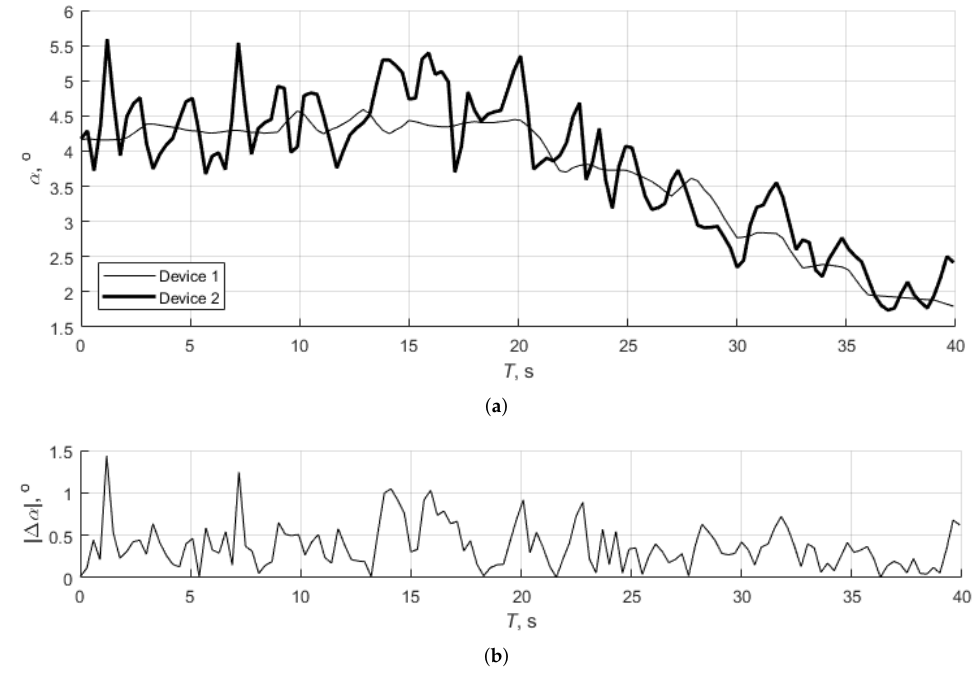
Figure 7. The estimated AoA: ( a ) using Devices 1 and 2; ( b ) absolute difference between the